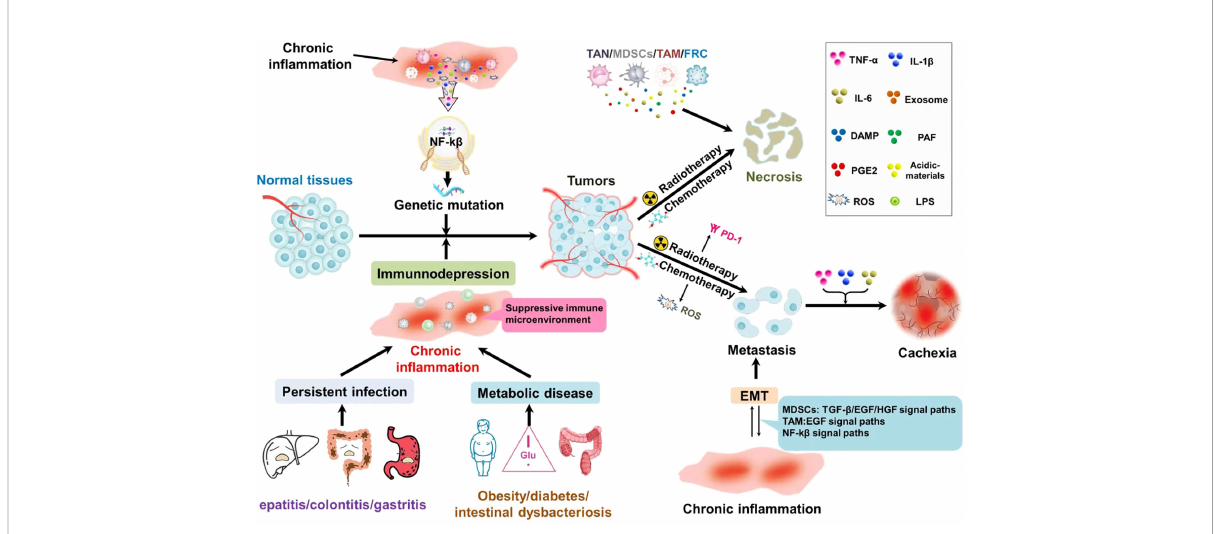
FIGURE 1 Chronic in fl ammation of different sources accompanies the whole process of tumor development: in precancerous lesions, chronic local irritation, and chronic in fl ammation caused by systemic metabolic diseases not only activate the NF- k B pathway, but also induce gene mutations that lead to tissue malignant transformation. At the same time, it can inhibit the immune monitoring and make the tumor cells escape. Tumor treatment could result in the necrosis of tumor cells. Necrosis of the tumor cells chemotactic in fl ammatory cell aggregation, suppression of immunity; At the same time, a large number of cytokines are released to generate factor storms leading to the aggregation and recurrence of tumor cells. Chronic in fl ammation and epithelial-mesenchymal transformation promote each other and form a vicious cycle, which is conducive to distant metastasis of tumors. In fl ammatory factors are closely related to the production of tumor